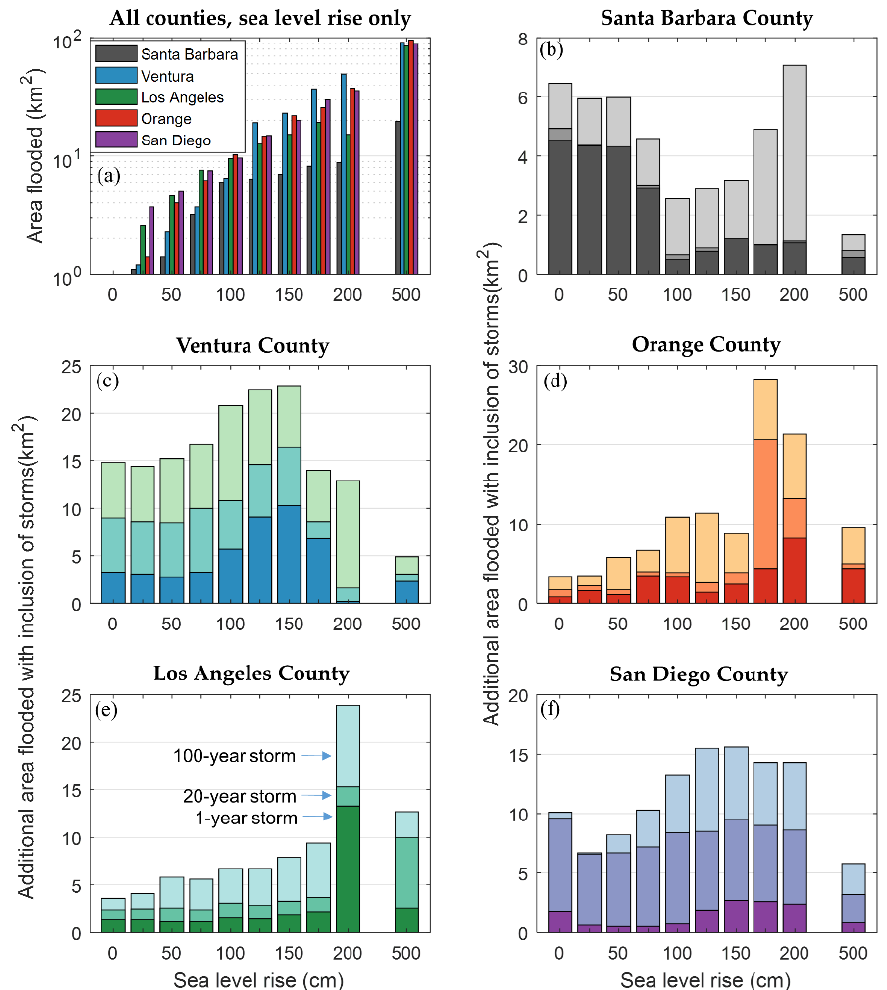
Figure 4. Areas projected to flood within each of the five coastal counties in Southern California due to sea-level rise (SLR) alone and in combination with coastal storms. ( a ) Total extents of flooded areas in each county for the SLR only scenario (no storm). Note the logarithmic vertical axis to capture the large differences between the 25 cm and 500 cm SLR scenarios; ( b – f ) Areas flooded beyond the SLR-only scenario, when the annual (darker color), 20-year, and 100-year (lightest color) costal storms are simulated in combination with